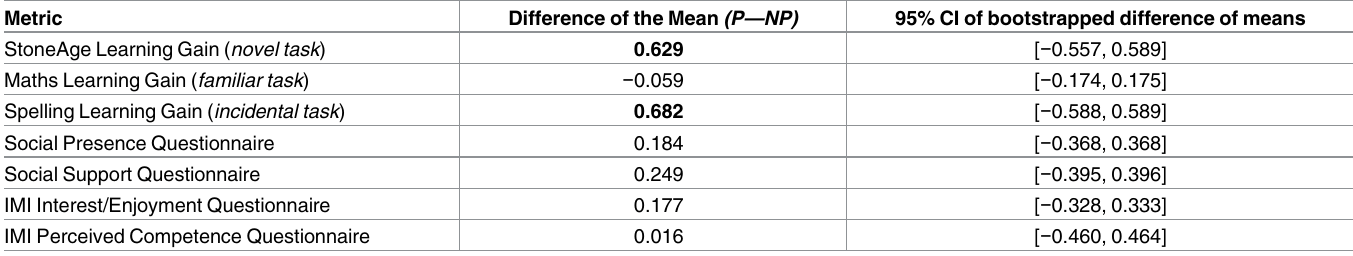
Table 3. End-of-Interaction Questions Bootstrapping. 10 6 replicationson the difference betweenthe conditions(P—NP), comparedto observed differ- ence. Numbers in bold denote that observed difference of means lies outsideof the bootstrapped 95% CI of the difference of